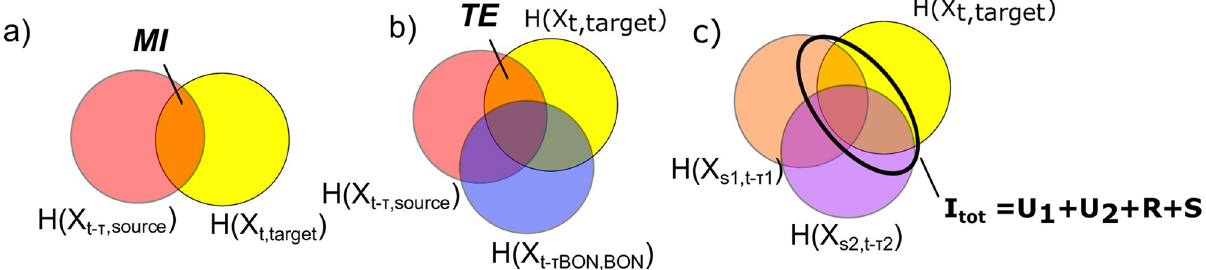
Fig 3. Venn diagrams illustrating range of information theory-based measures. (a) Mutual information ( MI ) between two random variables, where one is defined as a target and the other is a source that may be lagged in time. (b) Transfer Entropy ( TE ) between a source and target. Here we define TE as the MI conditioned on the knowledge of lagged salmon counts at BON. (c) Total mutual information, I tot , from two sources to a target is comprised of unique, synergistic, and redundant components.